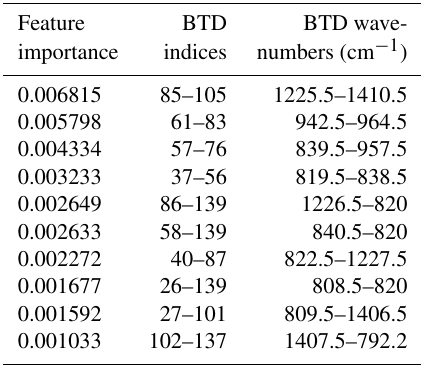
Table 3. Top ten list of BTDs providing maximum feature impor- tance as estimated by the RF